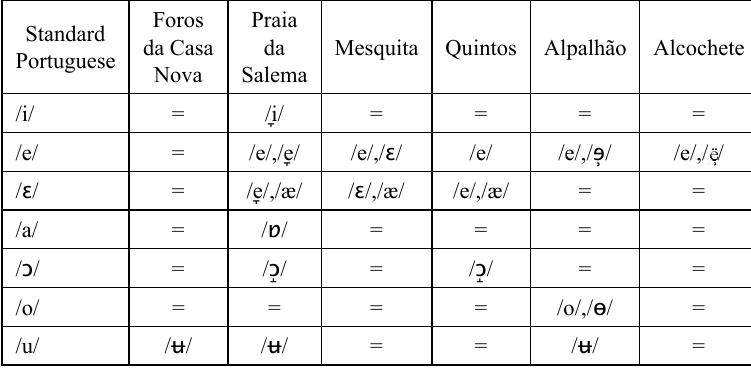
Table I. Standard Portuguese vs. different vowel